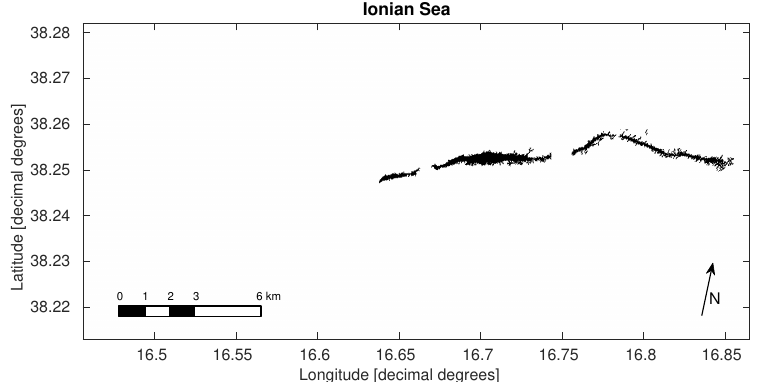
Figure 12. Classification performed on the Ionian Sea dataset segmented